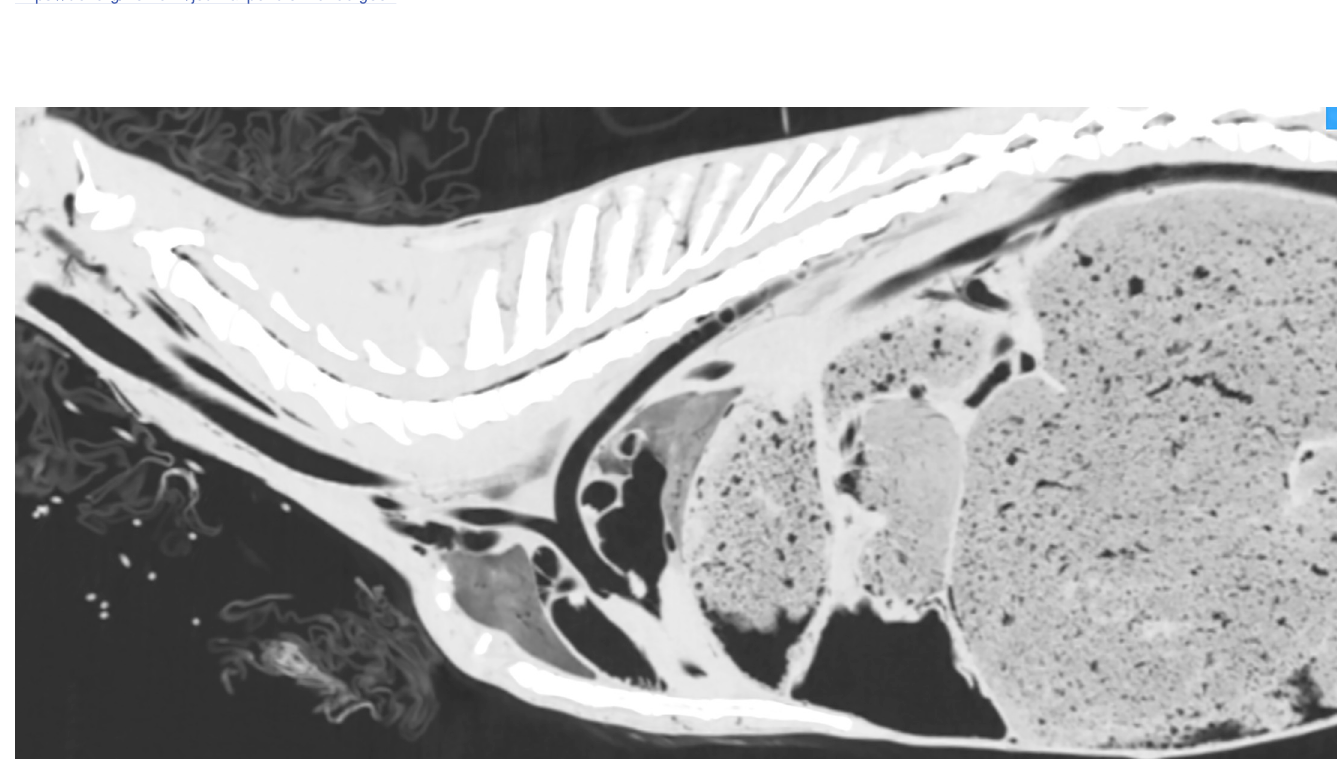
Fig 5. CT reconstruction in parasagittal plane after intra-arterial air inflation; lung window. Air-filled blood vessels and heart chambers visible.